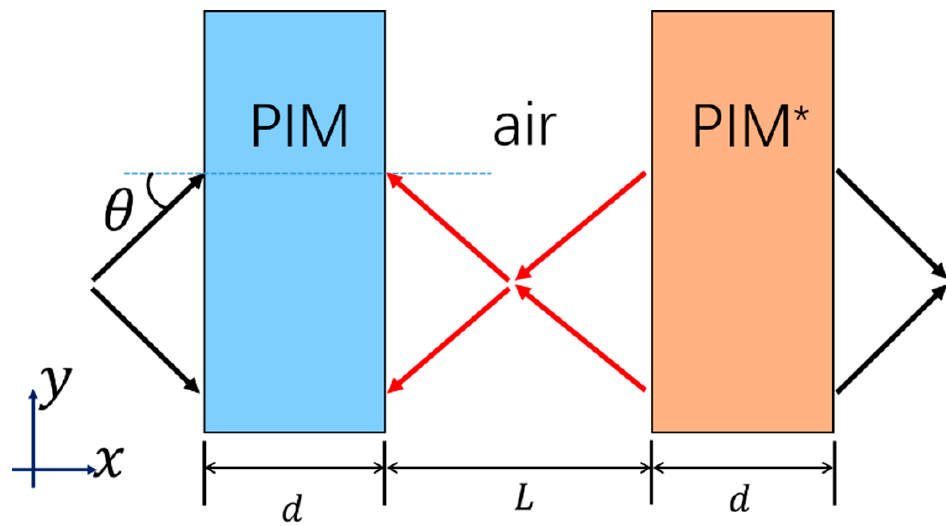
Figure 4. Schematic graph of the PIM-air-PIM* structure. The thickness d of both the PIM slab is 0.3 λ , and the length of the air gap L is 12 λ . Based on the above theoretical derivation (see Appendix B), the absolute values of refraction coefficient | r | and transmission coefficient | t | (in dB) are related to the incident angle θ and the refraction index n , are shown in Figure 5a,b. It can be seen that there is a dark blue curve extending from coordinate [0, 0.8] to coordinate [90, 1.2] in Figure 5a. On this curve, the reflection coefficient is almost zero, while the corresponding transmission is approximately one, as shown in Figure 5b. To verify whether such a response is a negative refraction or a resonance phenomenon, the scattering coefficients of the PIM* are calculated as shown in Figure 5c,d. It can be seen that there is a dark red curve with the same shape. Since the absolute values of the refraction coefficients | r | and transmission coefficients | t | tend to infinity (refer to the color bar), this curve corresponds to acoustic laser modes of the PIM* slab. As can been seen from the black dotted and dash lines in Figure 6a, the corresponding overall transmission coefficients | t | tend to unity, while the reflection coefficients | r | are almost zero. Thus, such a response is consistent with negative refraction in the PIM-air-PIM* structure, with one side working as a coherent power sink and the other as a power amplifier, while the overall transmission is